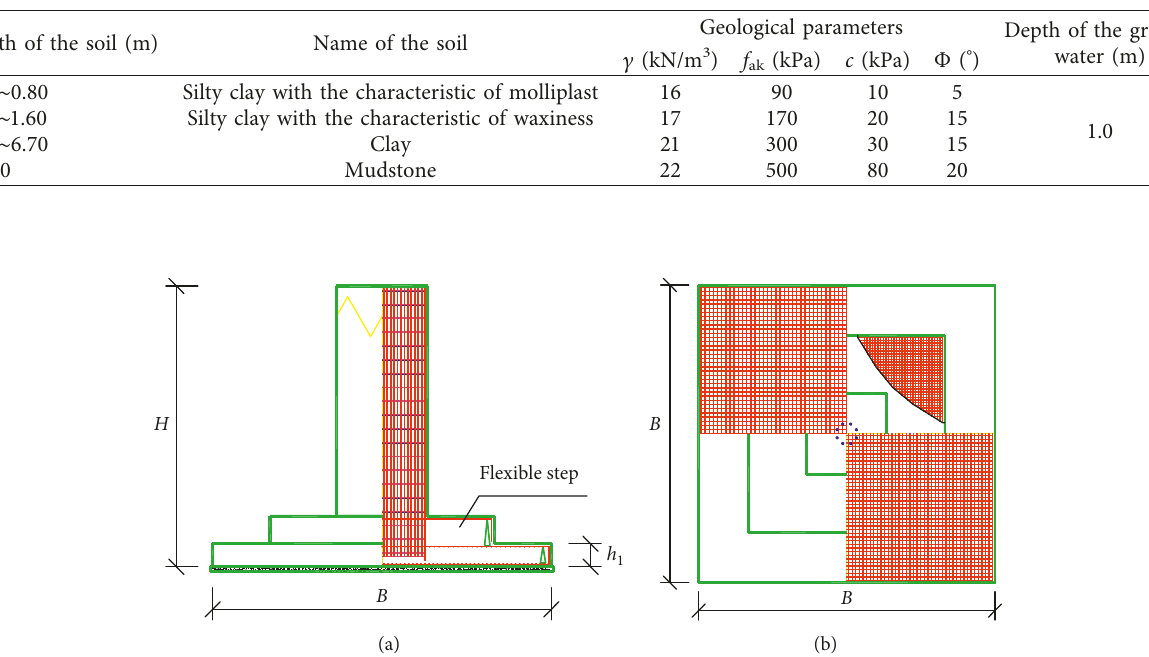
Table 10: Geological parameters for the design of the foundations.